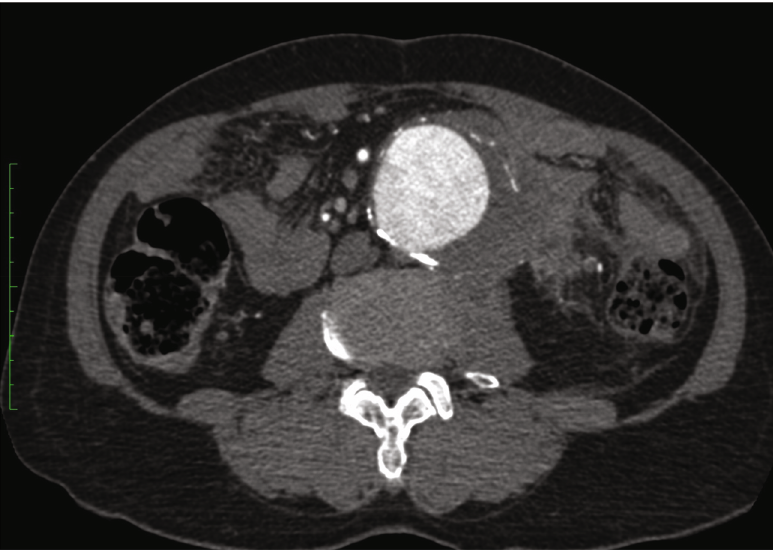
Figure 1: Preoperative CT scan revealed a large AAA with periaortic fat stranding.